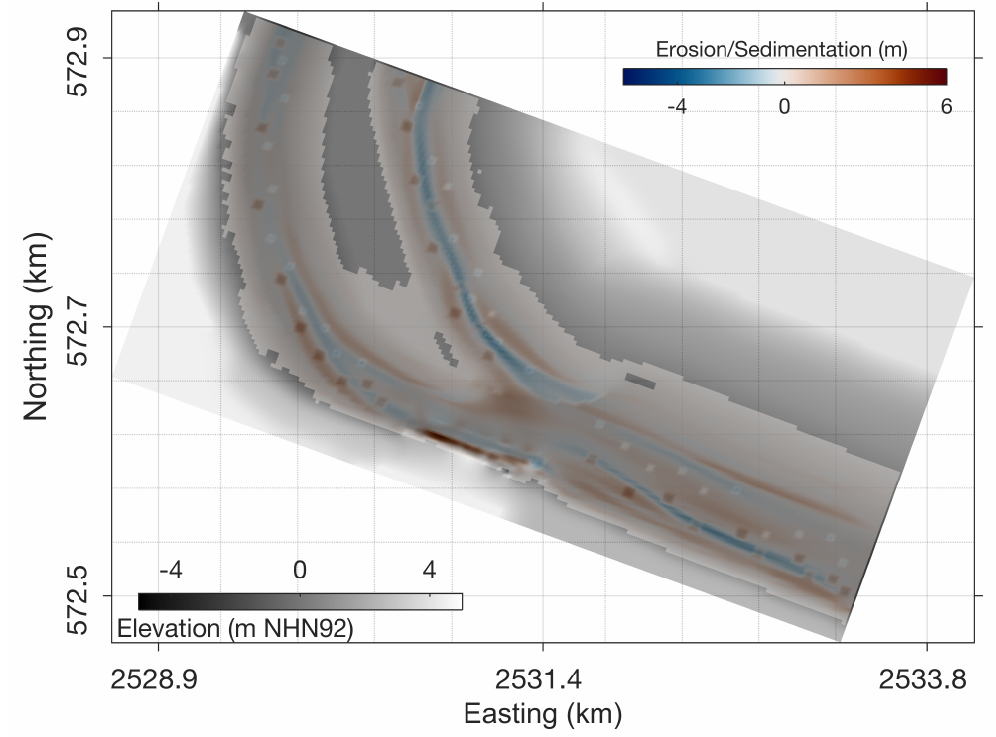
Figure 10. Initial bathymetry as grey-scale superimposed with cumulative erosion/sedimentation related changes after 20 year of morphodynamic simulation without any parametric representation of the harbour structures